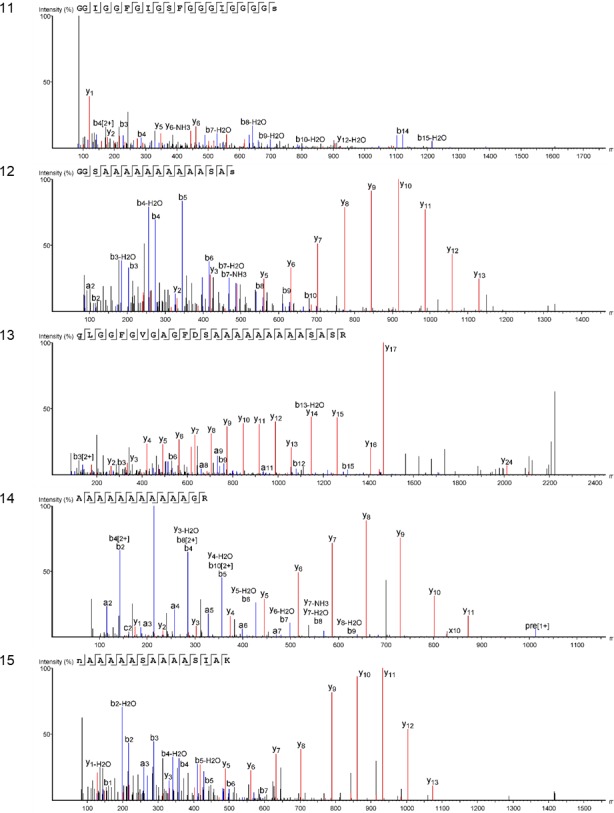
Product ion spectra [11 - 15] supporting the coverage of protein Hic74 identified in Unio pictorum.​